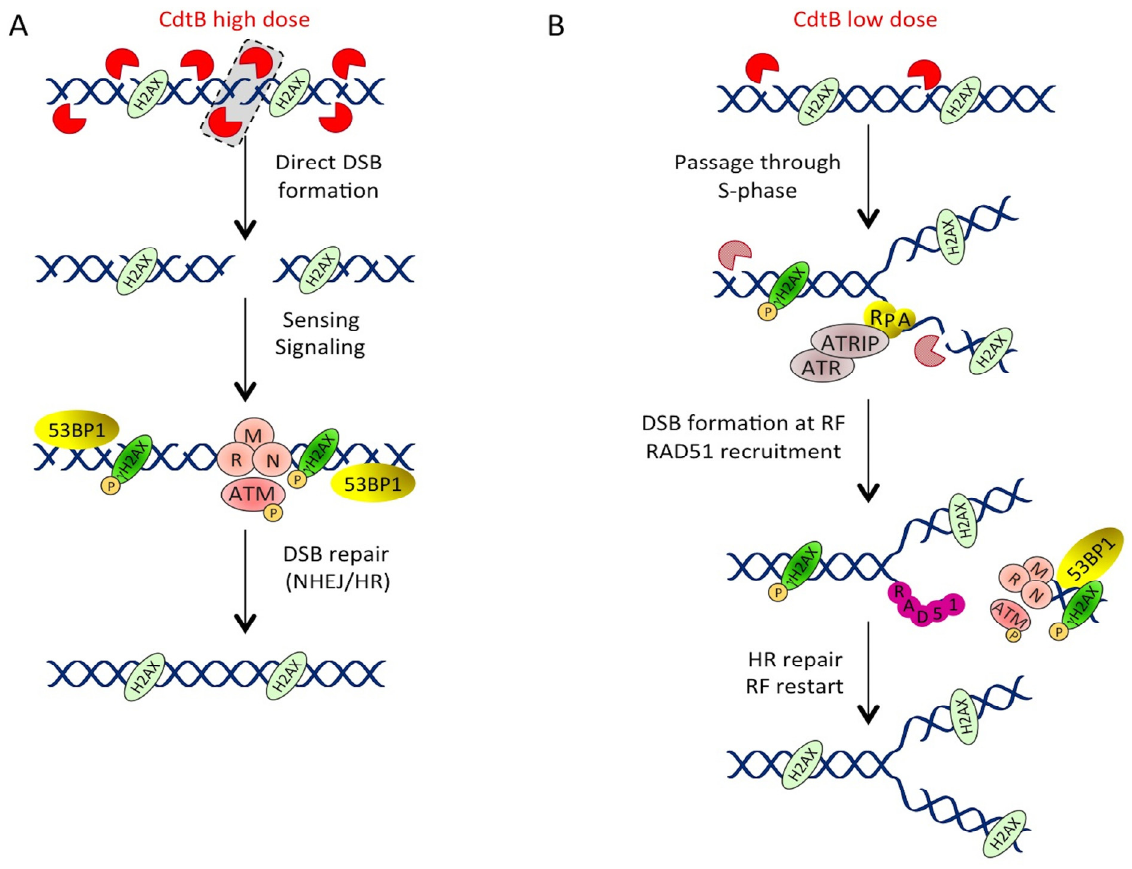
Figure 4. A model of CDT-mediated DSB formation and repair. ( A ) Direct DSB